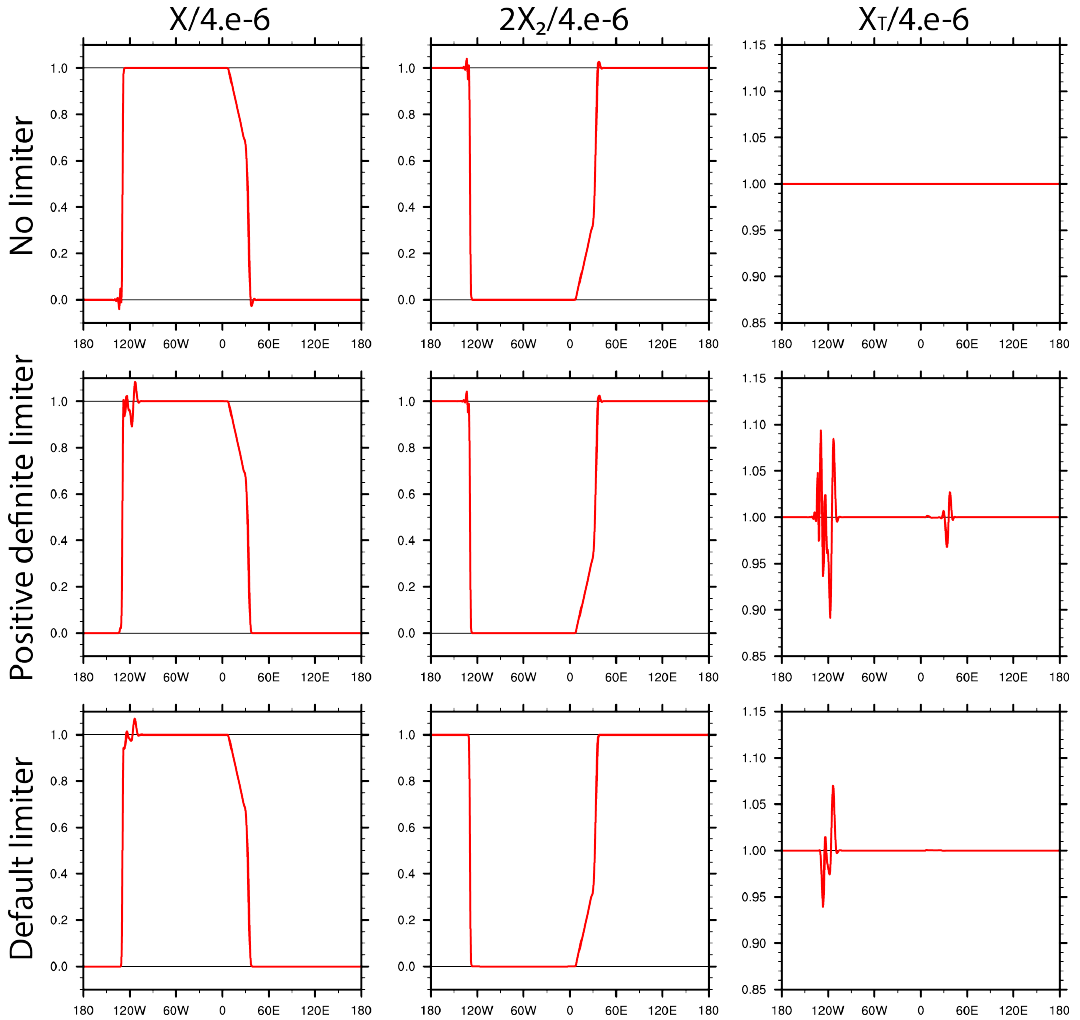
Figure 5. Cross sections of day 1 (left column) X, (middle column) 2 × X 2 , and (right column) X T at 45 ◦ S based on CAM-SE with (top row) no limiter, (middle row) positive definite limiter, (lower row) and default limiter, respectively. Results are normalized by 4 × 10 − 6 (the initial value of X T